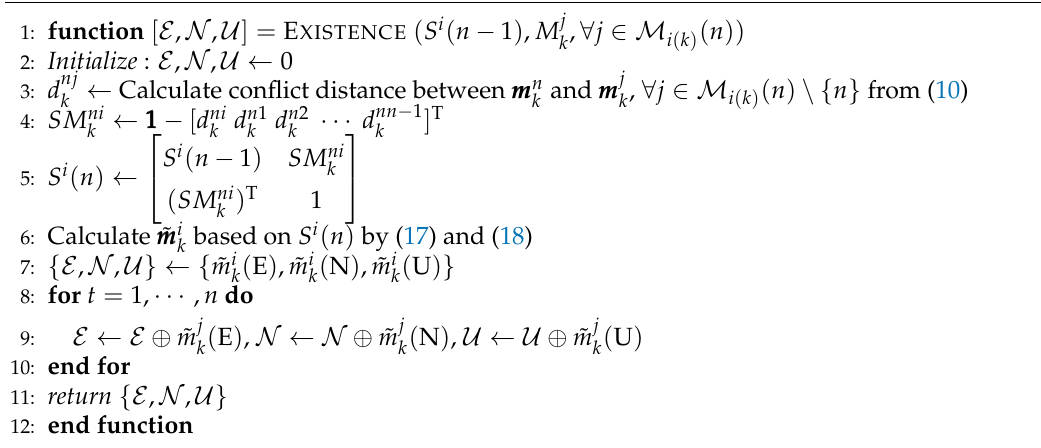
Algorithm 1 Existence calculation for i about object